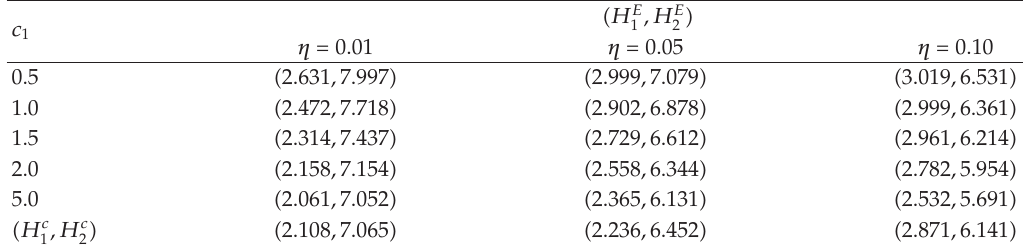
Table 2: HPD intervals of the shape parameter for the data set.